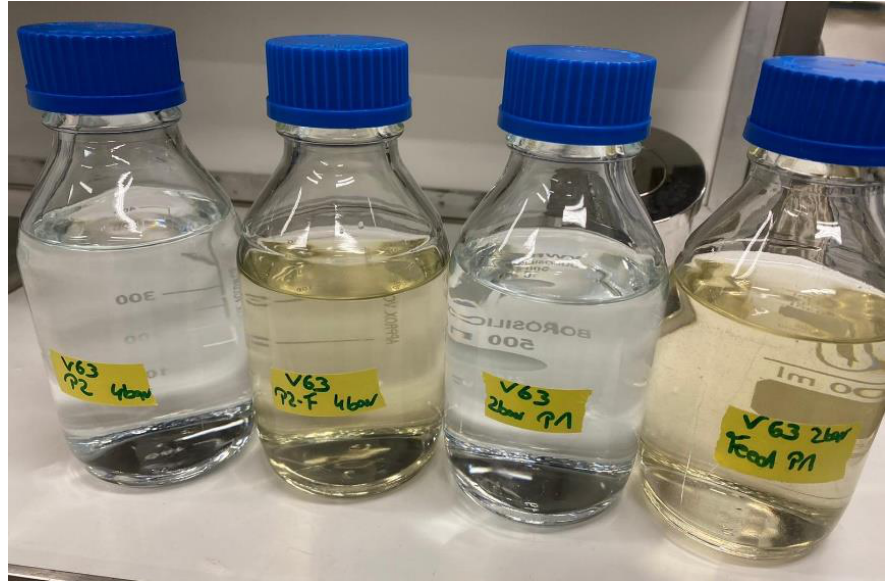
Figure 7. Photo of permeate and feed in an experiment with treated wastewater. From left to right: permeate at TMP = 4 bar, feed of the same experiment, permeate at TMP = 2 bar, and feed of the same experiment (Source: Oeltze).